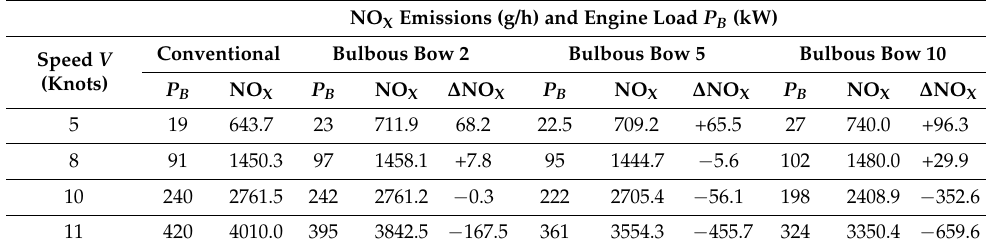
Table 6. NO X emissions (g/h) and engine load P B (kW) at various vessel speeds for the analysed bulbous bows.